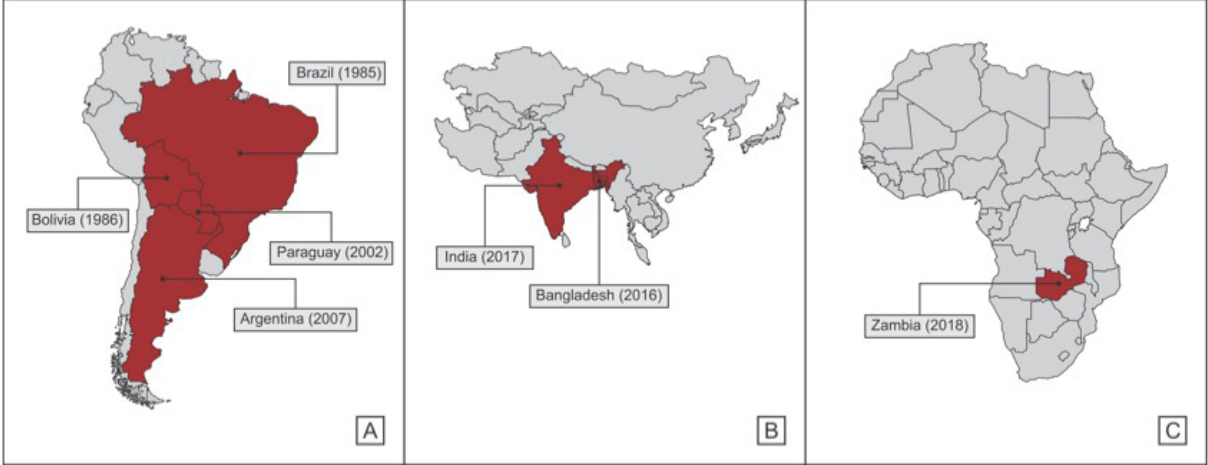
Figure 1 - Blast occurrence in different countries. A. Countries in the South American affected by blast and the year of the disease arrival; B. Countries in Asia affected by blast and the year of the disease arrival; C. Country on the African continent affected by blast and the year of the disease